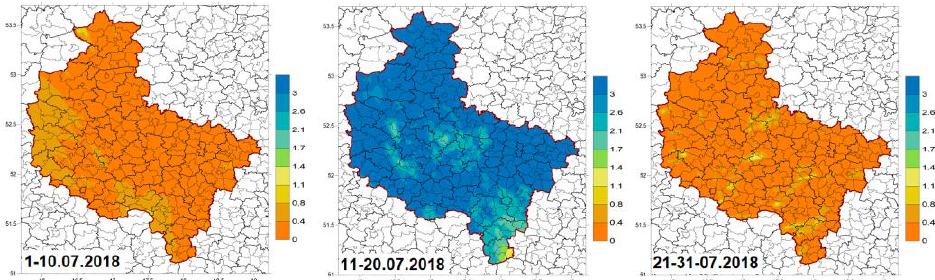
Figure 7. Hydrothermal coefficient (HTC) values for individual 10-day periods in July 2018. Ground and satellite data also make it possible to track the daily, ten-day, monthly or even seasonal or annual course of individual indices depicting the conditions of plant cultivation. The compilation of the entire spectrum of indices shows a picture of the